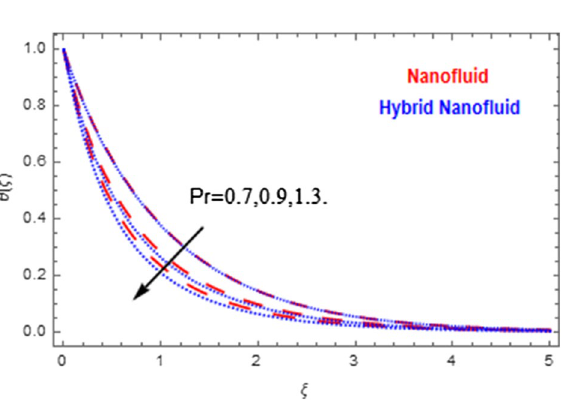
Figure 16. Variation in temperature field of nanofluid ( Al 2 O 3 ) and hybrid nanofluid ( Al 2 O 3 , Cu ) against different estimations of Pr .